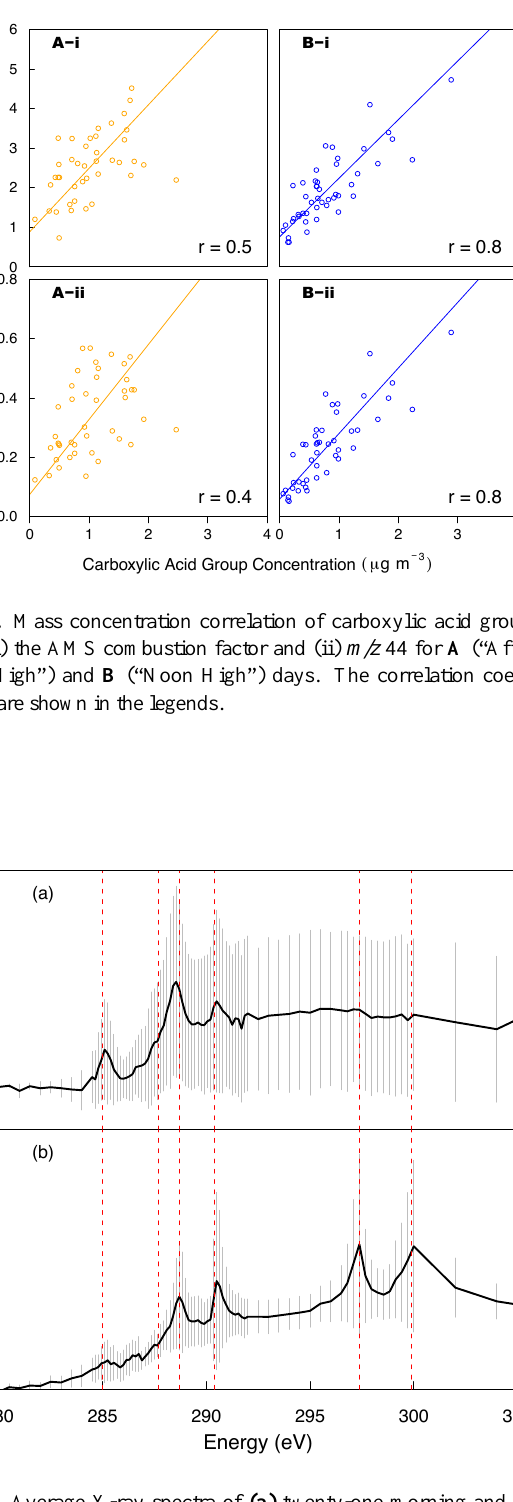
Fig. 7. Average X-ray spectra of (a) twenty-one morning and (b) Fig. 7. See list of figure captions. sixteen afternoon particles. Grey vertical bars indicate the standard deviations of absorption at corresponding energies. Red vertical lines indicate alkene group (285eV), alkane group (287.7eV), car- boxylic acid group (288.7eV), carbonate (290.4eV), and K (297.4 and 299.9eV)